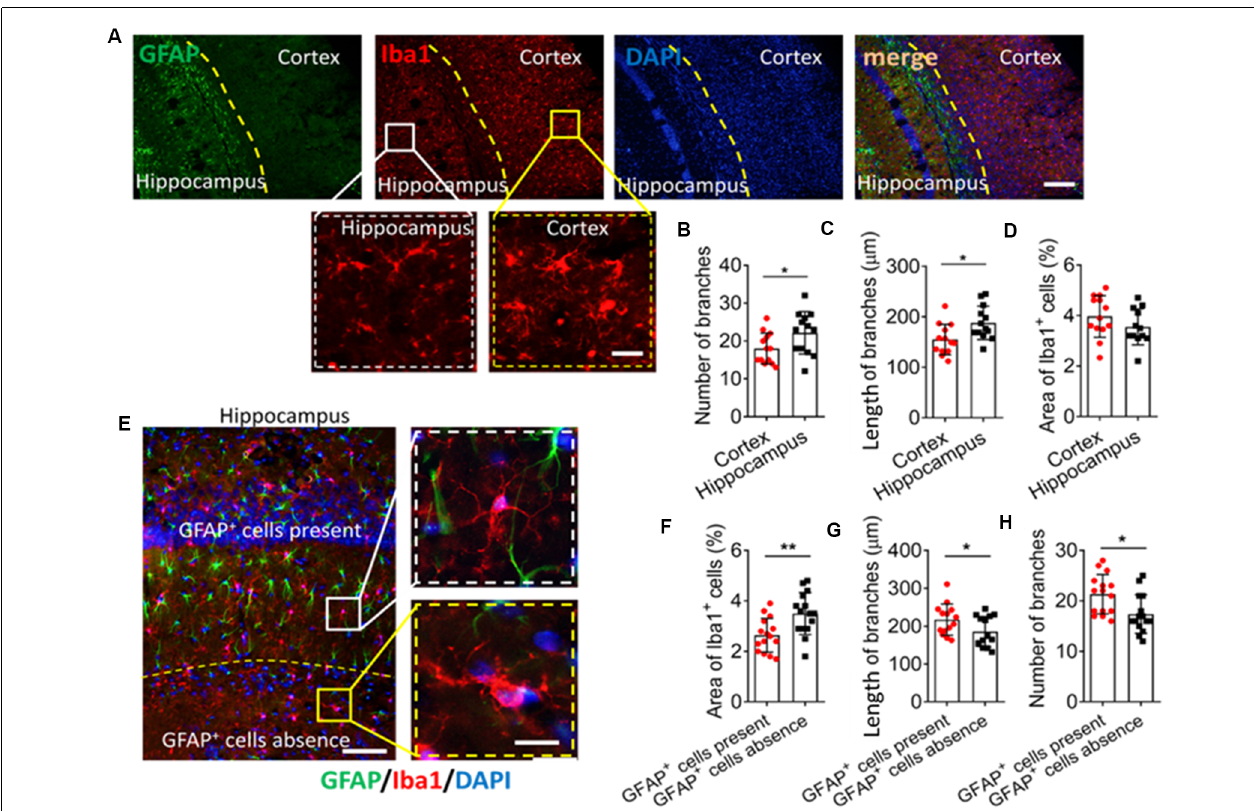
FIGURE 1 | GFAP + cells are involved in microglial ramification in the brain. (A) Fluorescence micrographs showing microglia and astrocyte in the mouse cortex and hippocampus. Microglia were labeled by Iba1 (red), astrocytes were labeled by GFAP (green), and nuclei were labeled by DAPI (blue). Scale bar, 100 µ m. The zoomed insets highlight differences in microglial morphology between the cortex and hippocampus. Scale bar, 20 µ m. ( B–D) The number (B) and length (C) of branches, and percentage of Iba + cells (D) in the hippocampus and cortex. (E) Fluorescence micrographs showing microglia and astrocytes in mouse hippocampus. Microglia were labeled by Iba1 (red), astrocytes were labeled by GFAP (green), and nuclei were labeled by DAPI (blue). Scale bar, 50 µ m. The zoomed insets highlight differences in microglial morphology in regions where GFAP + cells were present or absent. Scale bar, 10 µ m. (F–H) Percentage of Iba + cells (F) ; length (G) and number (H) and of branches in regions where GFAP + cells were present or absent ( n = 4–5 animals/group). Results of each group were obtained from 4 independent samples, and 5–6 micrographs were collected from each sample. All Iba1 + cells in each micrograph were measured. Each dot in the bar graph represents the average of all Iba1 + cells in a micrograph. Data are presented as mean ± SEM ( n = 20–24), * P < 0.05 and ** P < 0.01 vs. corresponding controls (unpaired t